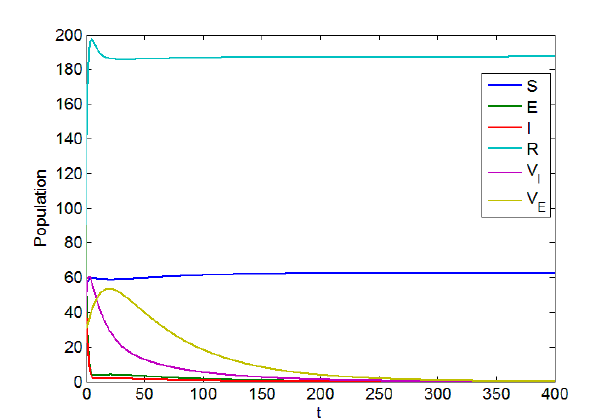
Figure 1. Diagram of the local asymptotic stability of the disease-free equilibrium point. (a)